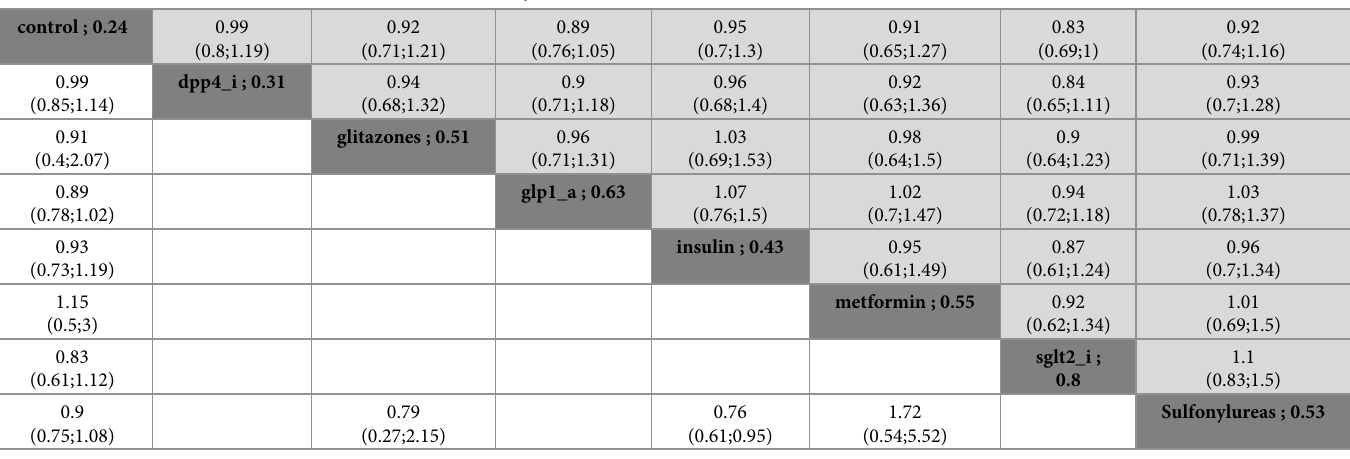
Table 3. Treatment effect estimates for cardiovascular